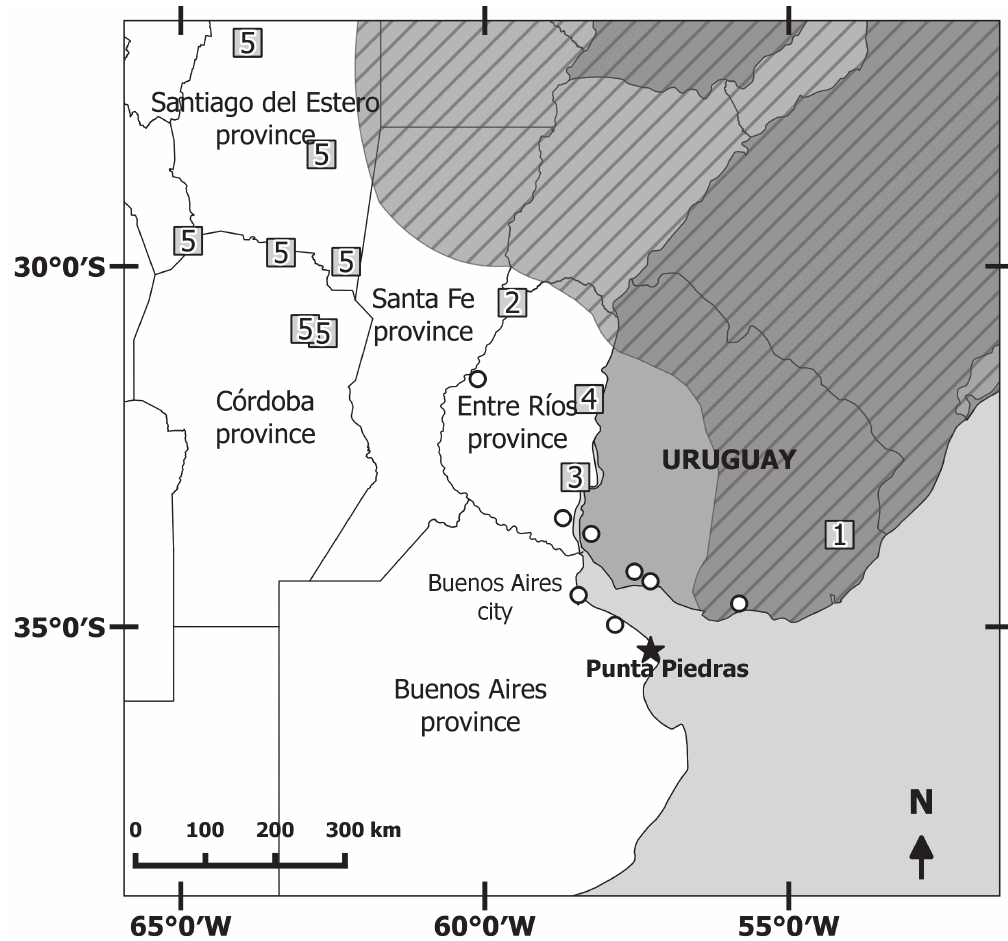
Figure 1. Distribution of Lesser Yellow-headed Vulture ( Cathartes burrovianus ) in southern South America (gray with stripes) according to Ferguson-Lees and Christie (2001), with indications of published records (numbered squares), records available in eBird (2018) and EcoReg- istros (2018) (white circles) and new record by this study (black star). [1] = Tremoleras (1927), [2] = De La Peña (1996), [3] = Aves Argentinas (2009), [4] = Marateo et al. (2009), [5] = Paulini et al.